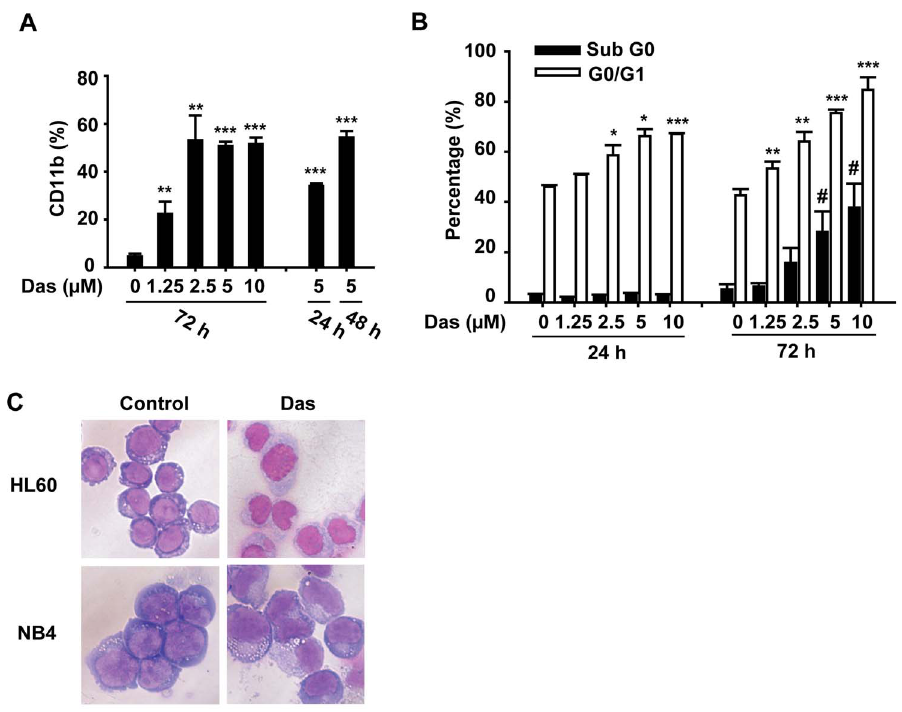
Figure 2. Dasatinib induces differentiation of NB4 cells. NB4 cells were treated with different concentrations of dasatinib for the indicated times. (A) The percentages of CD11b expression cells were determined as described. Data presented are the mean 6 SD of three independent experiments. *** P , .001, ** P , .01 versus vehicle treated cells. (B) Cell cycle proportion was analyzed as described. Data presented are the mean 6 SD of three independent experiments. *** P , .001, ** P , .01, */ # P , .05 versus vehicle treated cells. (C) HL60 cells were treated with dasatinib (10 m M) for 72 h and NB4 cells were treated with dasatinib (5 m M) for 48 h. Cells were collected and cytospined onto slides, then stained with Wright–Giemsa stain. Stained cells were observed under microscope ( 6 40). The data are representative of three independent